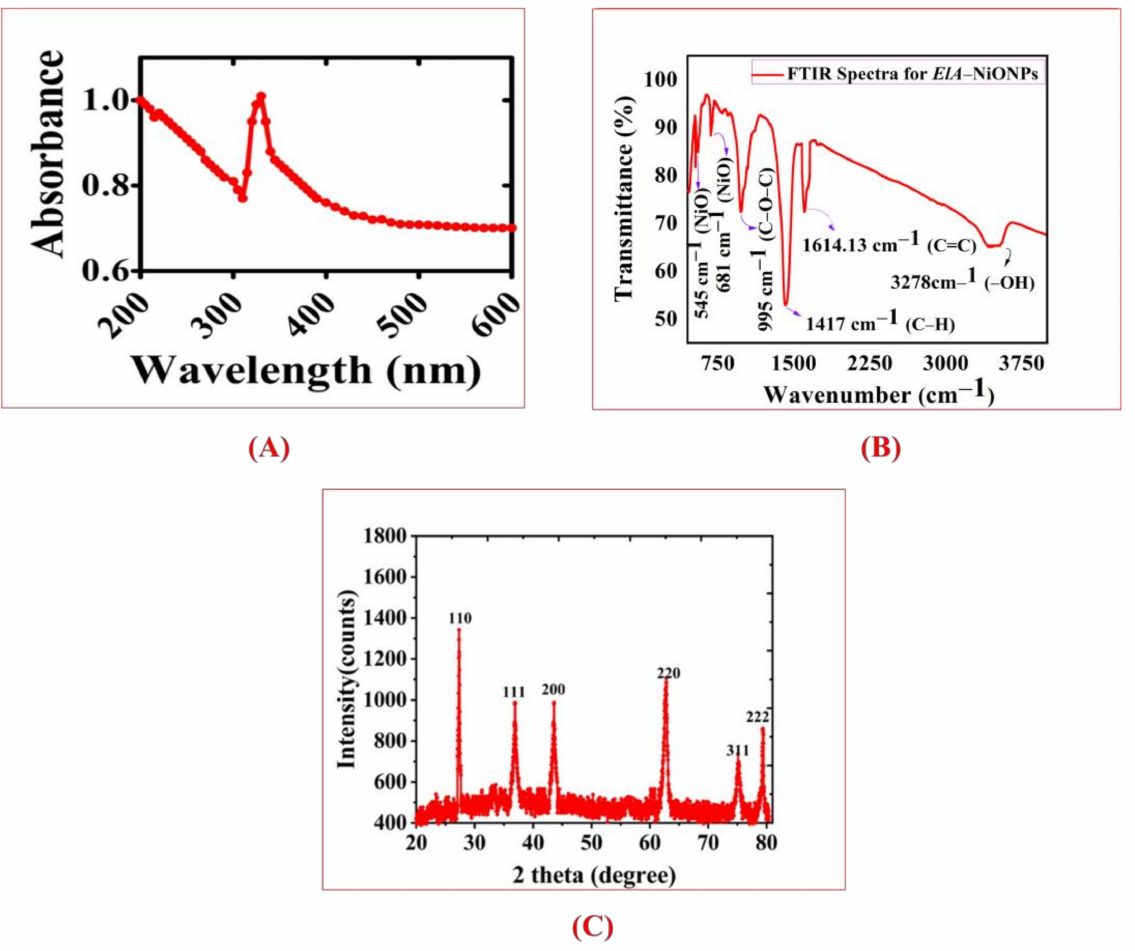
Figure 3. Spectral analysis of E. angustifolia mediated NiONPs; ( A ) UV spectra; ( B ) FT-IR transmission spectra; ( C ) XRD studies of